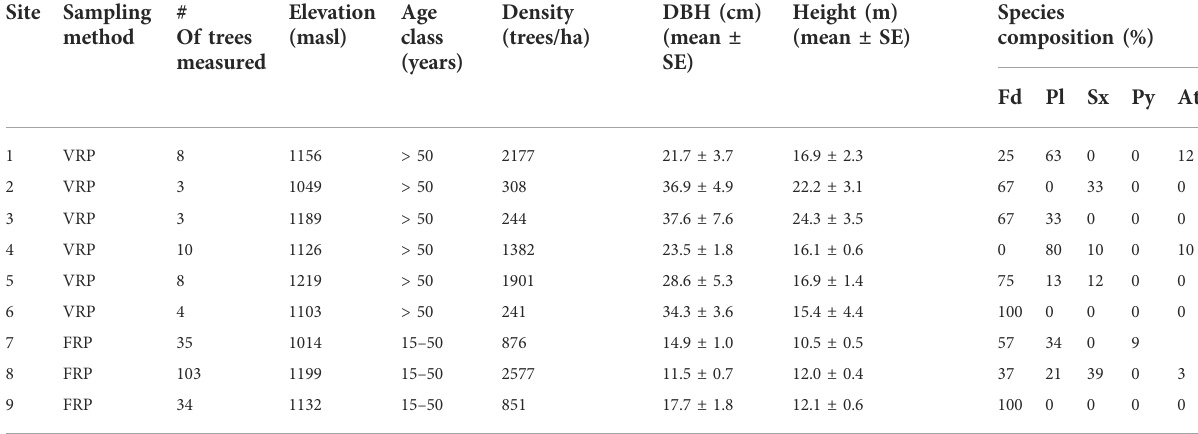
TABLE 1 The pre- fi re fi eld information of each study site (VRP — variable-radius plot, FRP — fi xed-radius plot, masl — meters above sea level, SE — standard error, Fd — Douglas- fi r, Pl — lodgepole pine, Sx — hybrid spruce, Py — ponderosa pine, At — trembling aspen) Site Sampling